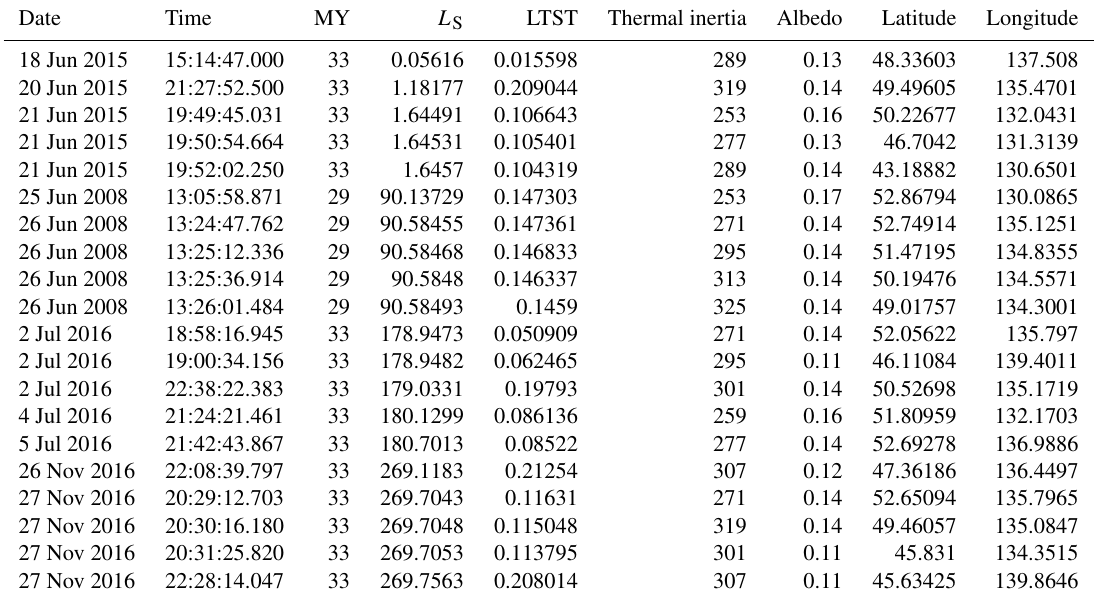
Table A2. MCS sounding details, thermal inertia and albedo for the VL-2 site.